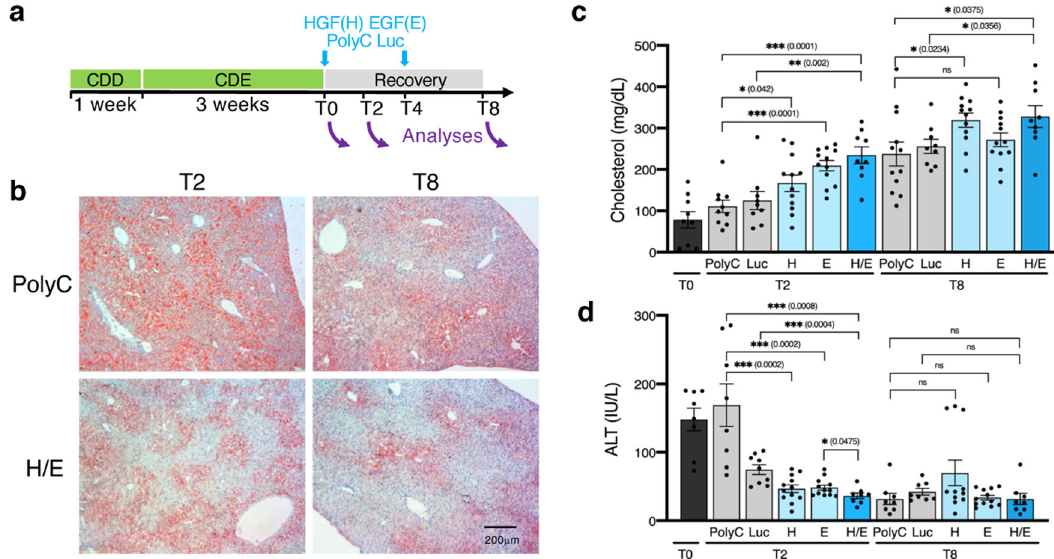
Fig. 4 HGF/EGF mRNA-LNP accelerate restoration of liver function during recovery from CDE-induced chronic liver injury. a Injury scheme timeline: mice were fed CDD choline de fi cient diet for 1 week followed by three weeks of CDD diet supplemented with 0.1% ethionine (CDE). The CDE diet was then replaced with choline-suf fi cient diet. Mice were injected with either controls Poly(C) RNA or Luc mRNA-LNP, or HGF(H) and EGF(E) single or combined (H/E) mRNA-LNP at the end of the CDE diet (T0), followed by another injection 4 days into recovery (T4). b Bright- fi eld images at ×100 magni fi cation of Oil Red O staining showing lipid accumulation in hepatocytes at T2 and T8 in mice injected with either Poly(C) RNA-LNP or H/E mRNA-LNP. Representative images from 3 to 4 mice per group are shown. The scale bar represents 200 μ m for all ×100 magni fi cation images. Analyses of total serum cholesterol levels ( c ) and ALT levels ( d ) from 3 to 4 mice per group in duplicate or triplicate ( n = 8 – 12) per time point treated with controls Poly(C) RNA- LNP or Luc mRNA-LNP, or single HGF(H), single EGF(E) or the combination H/E mRNA-LNP indicate sharp reversion of steatosis and restoration of basic levels of ALT after H/E mRNA-LNP injections. Data are presented as mean values ± SEM. Dark grey: T0, light grey: control RNA, light blue: single mRNA, dark blue: combined mRNA. P values were calculated by two-sided student ’ s t test, ***<0.0001, **<0.001, *<0.05, n.s. = not signi fi cant. Source data are provided as a Source Data fi